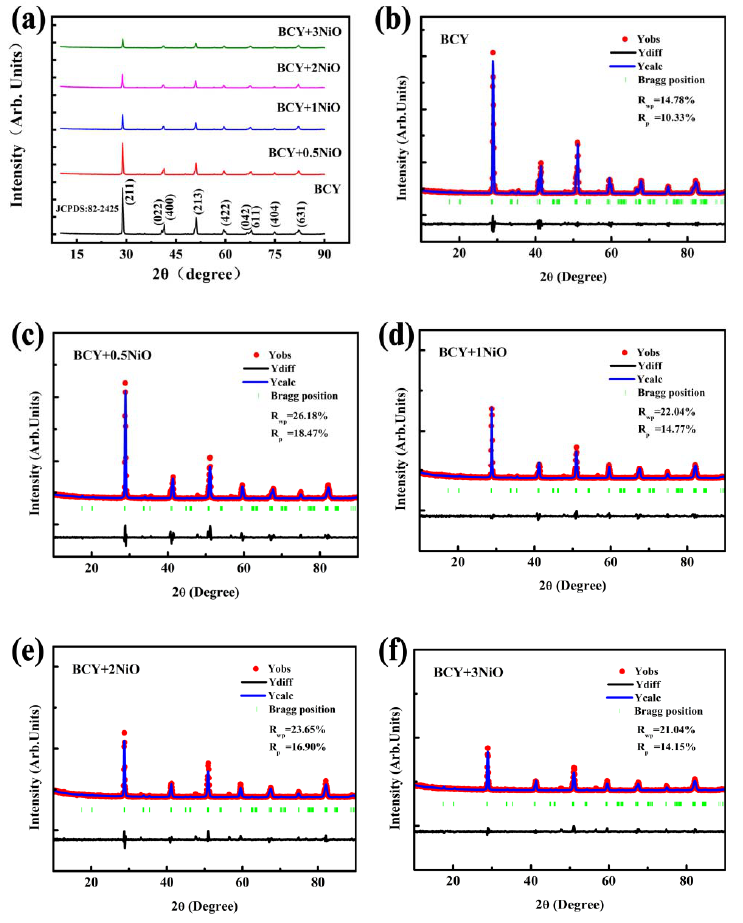
Figure 2. ( a ) XRD patterns of BCY–NiO powder samples calcined at 1400 ◦ C for 5 h; ( b – f ) XRD Rietveld refinement results of BCY–NiO powder samples.